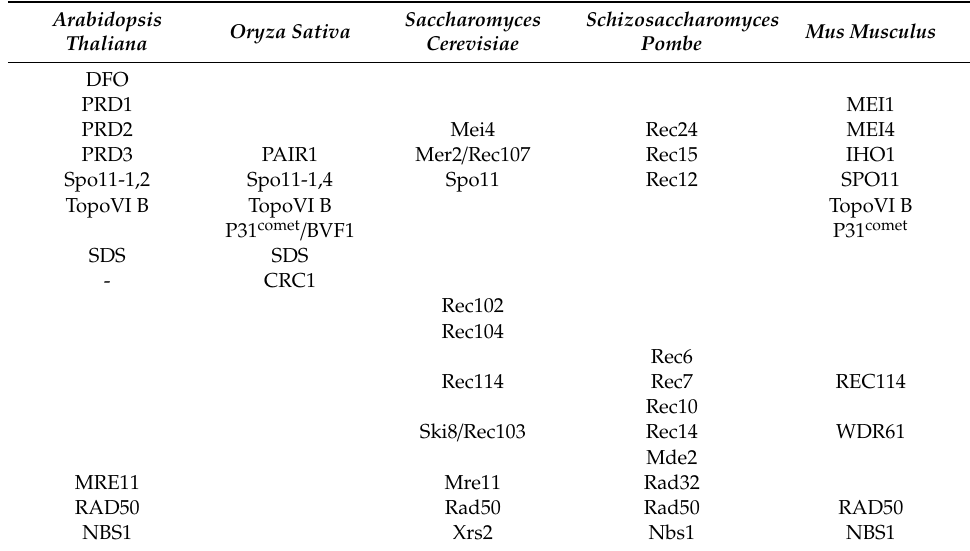
Table 1. Characterized proteins involved in meiotic double-strand breaks (DSB) formation in di ff erent